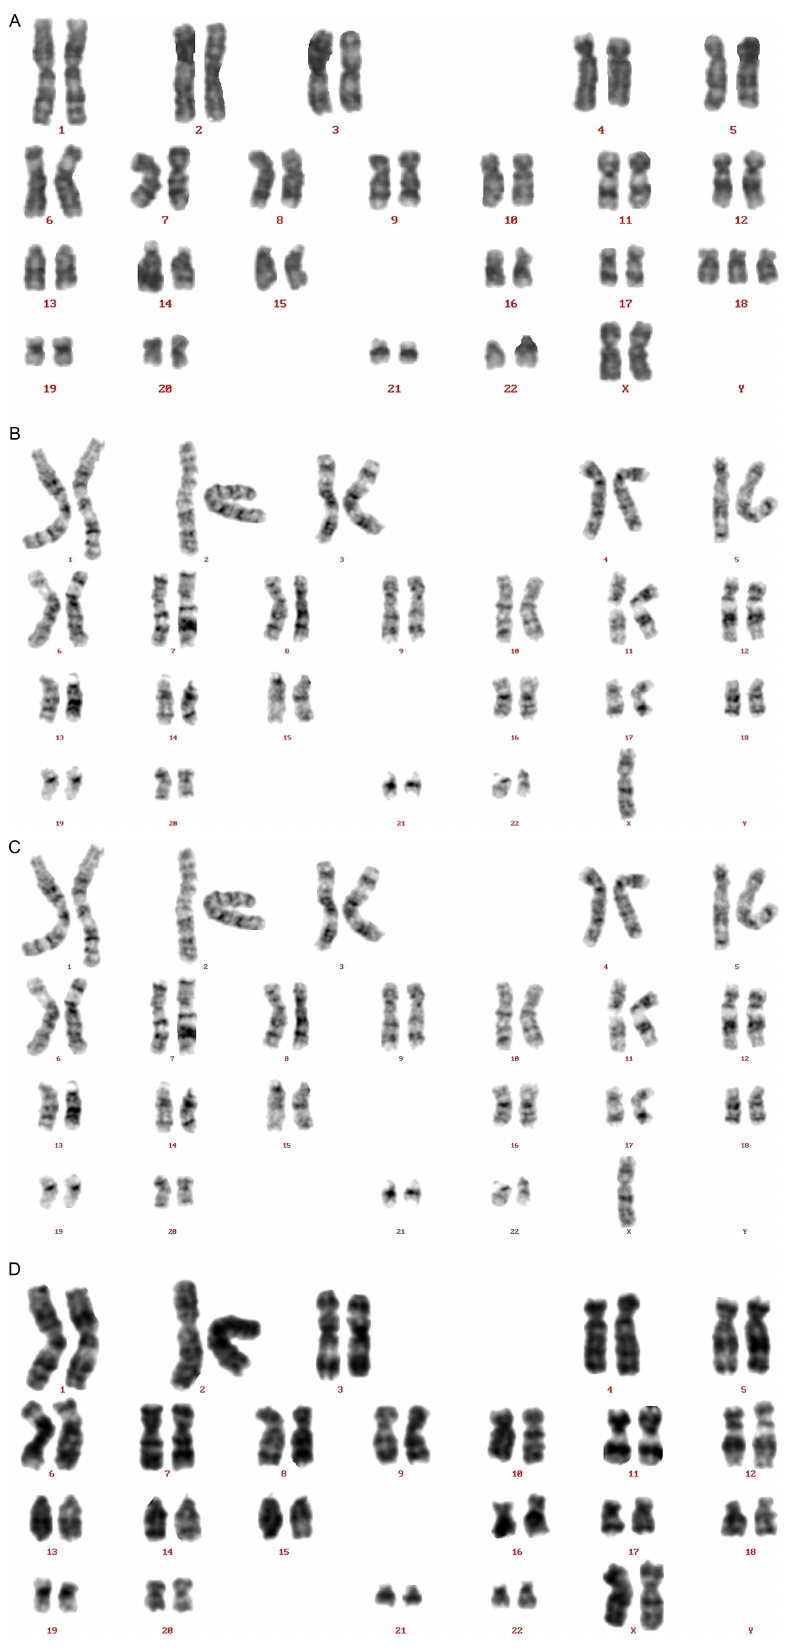
Figure 2. A-D. Karyotypes of patients included in the study. A. Normal woman (ID: 0245, 46,XX). B. Woman with free trisomy 21 (ID: 0035, 47,XX,+21). C. Woman with Turner’s syndrome (ID: 0105, 46,X). D. Woman with free trisomy 18 (ID:0024, 47,XX,+18). GTG banding, 100 ×